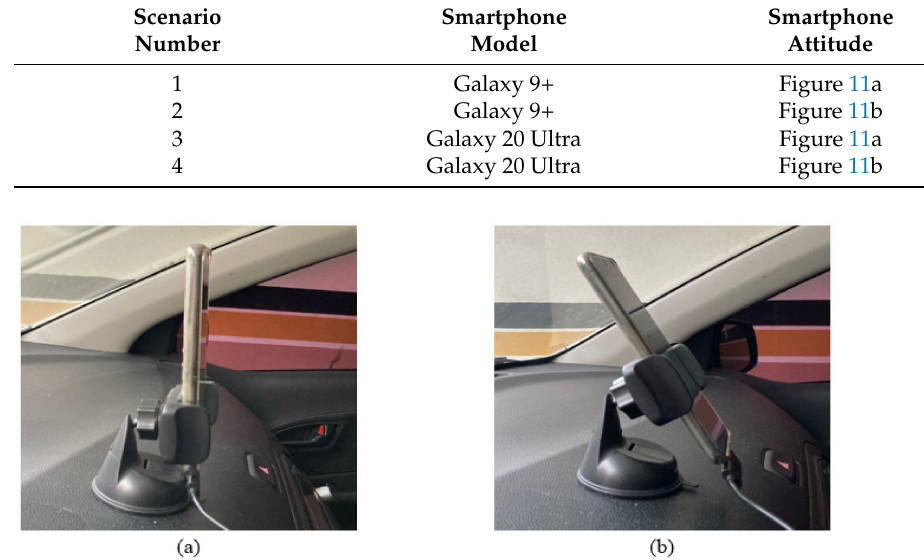
Figure 11. Smartphone attitude of ( a ) first, third scenarios, ( b ) second, fourth